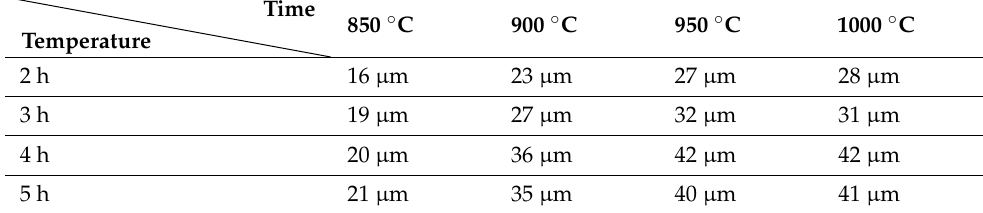
Table 3. Boronizing layer thickness at different temperature and